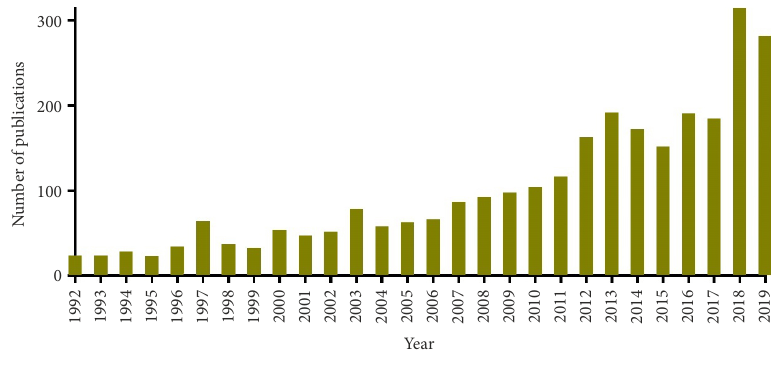
Figure 2. The distribution of publications by year Table 2. Annual publication and citation structure in AutCon according to the